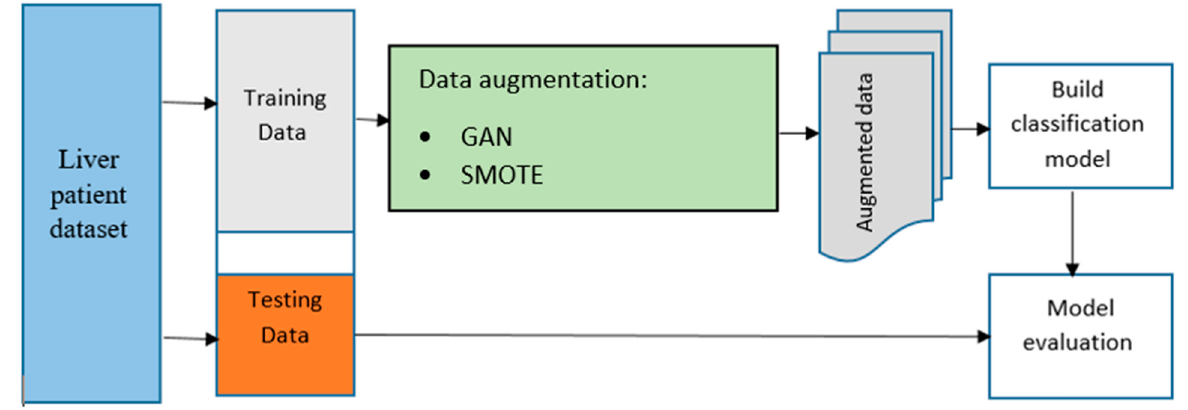
Figure 4. The architecture of the proposed approach.